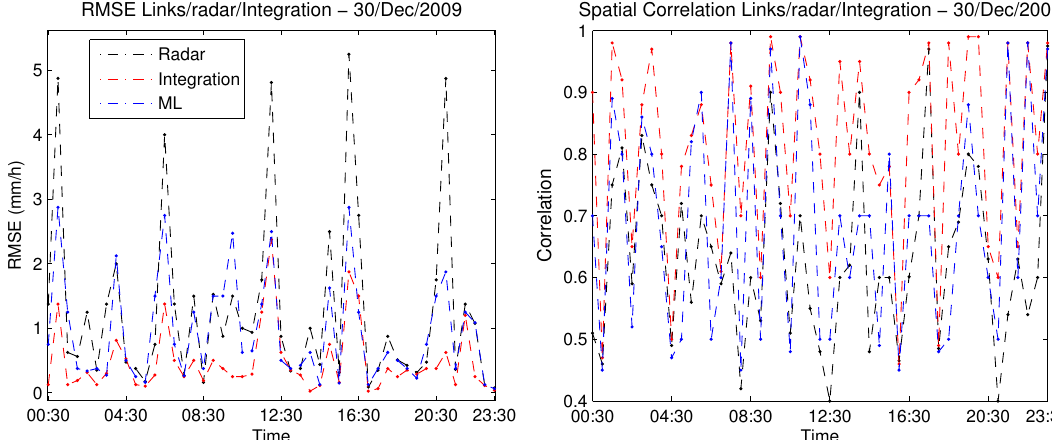
Figure 9. Evaluation analysis of event 3, where the radar (black line), the proposed integration technique (red line) and ML (blue line) are compared to the rain gauges at the common times. Left: RMSE. Right: spatial correlation.